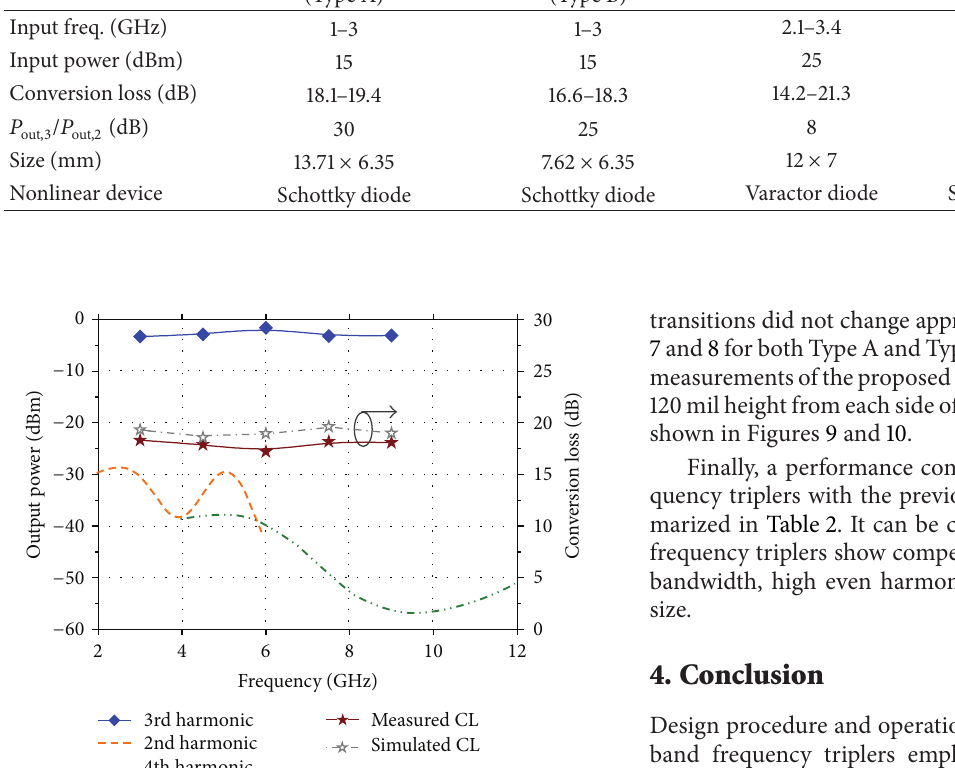
Figure 10: Simulated and measured results of conversion loss and measured results of output powers with respect to output frequency (Type B